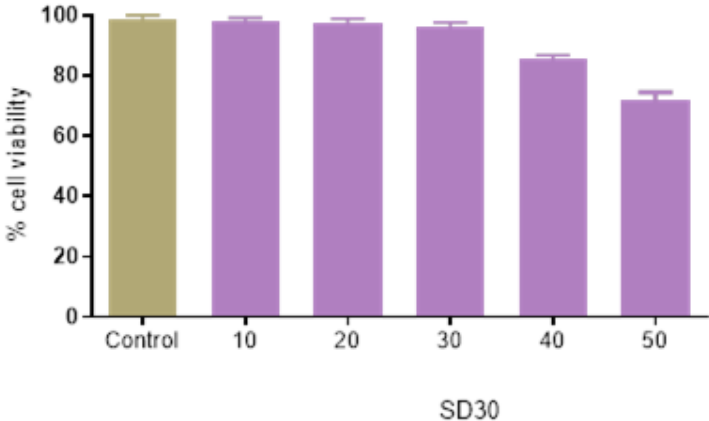
Figure 2. Cell toxicity study on SH-SY5Y cell line at five different doses.